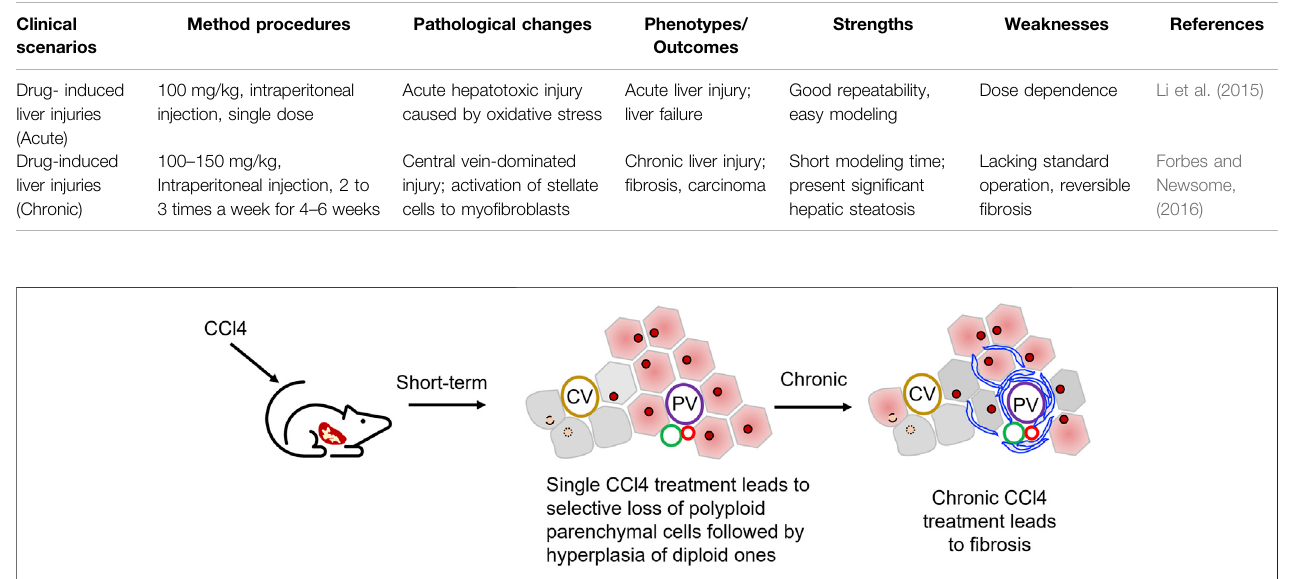
FIGURE 1 | Use of carbon tetrachloride, CCl4, to establish liver injury models. CCl4 administration leads to the damages of hepatocytes in hepatic central zone. Normally a single dose of CCl4 will show acute liver injury phenotype as pericentral necrosis and steatosis, while the prolonged administration causes fi brosis, cirrhosis, or